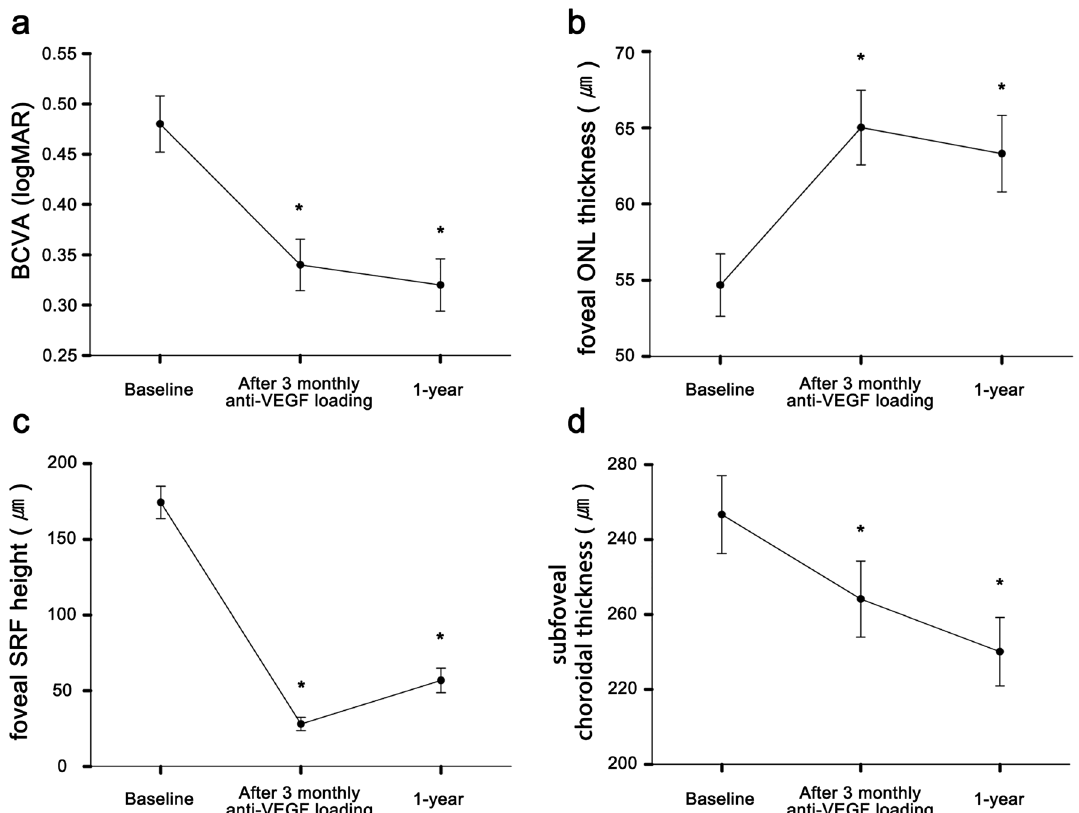
Figure 1. Changes in best-corrected visual acuity (BCVA) and optical coherence tomography (OCT) biomarkers during treatment in type 1 choroidal neovascularization. After intravitreal anti-vascular endothelial growth factor (VEGF) treatment, BCVA improved significantly ( a ). Simultaneously, a decreased foveal outer nuclear layer (ONL) thickness also recovered partially ( b ). The foveal subretinal fluid (SRF) height and subfoveal choroidal thickness also decreased ( c and d ). These improvements were maintained during the 12.2 ± 0.9- month follow-up period comprising 7.1 ± 3.8 intravitreal anti-VEGF injections. Asterisks indicate a significant difference from the baseline